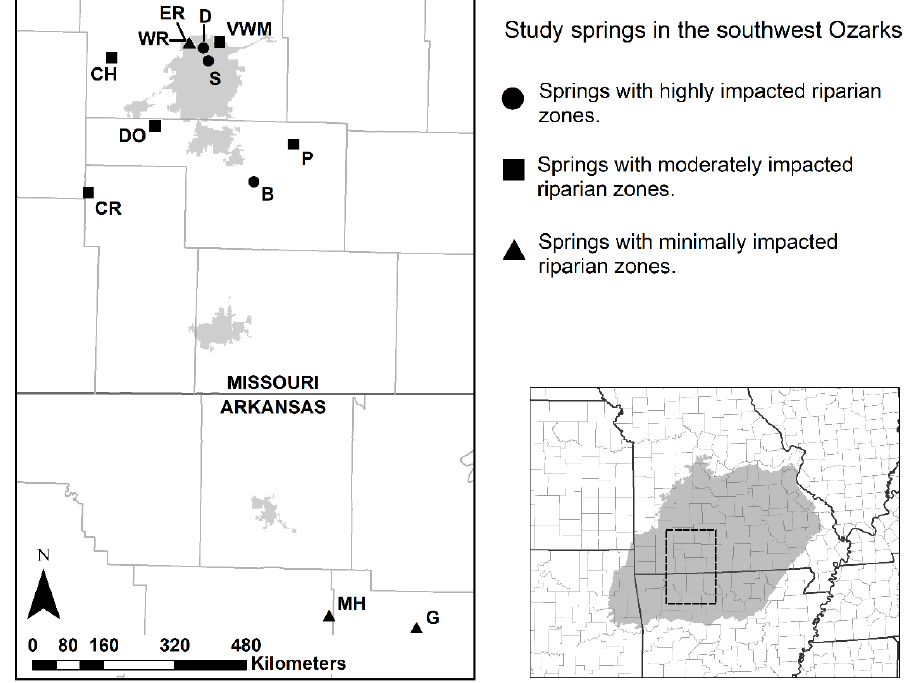
Figure 1. Map of the stream locations in the Ozark Plateau region of Arkansas and Missouri. This map was created with ArcMap 10.5.1 GIS software [43]. Site abbreviations are defined in Table 1 and site-specific coordinates can be found in Table S1.